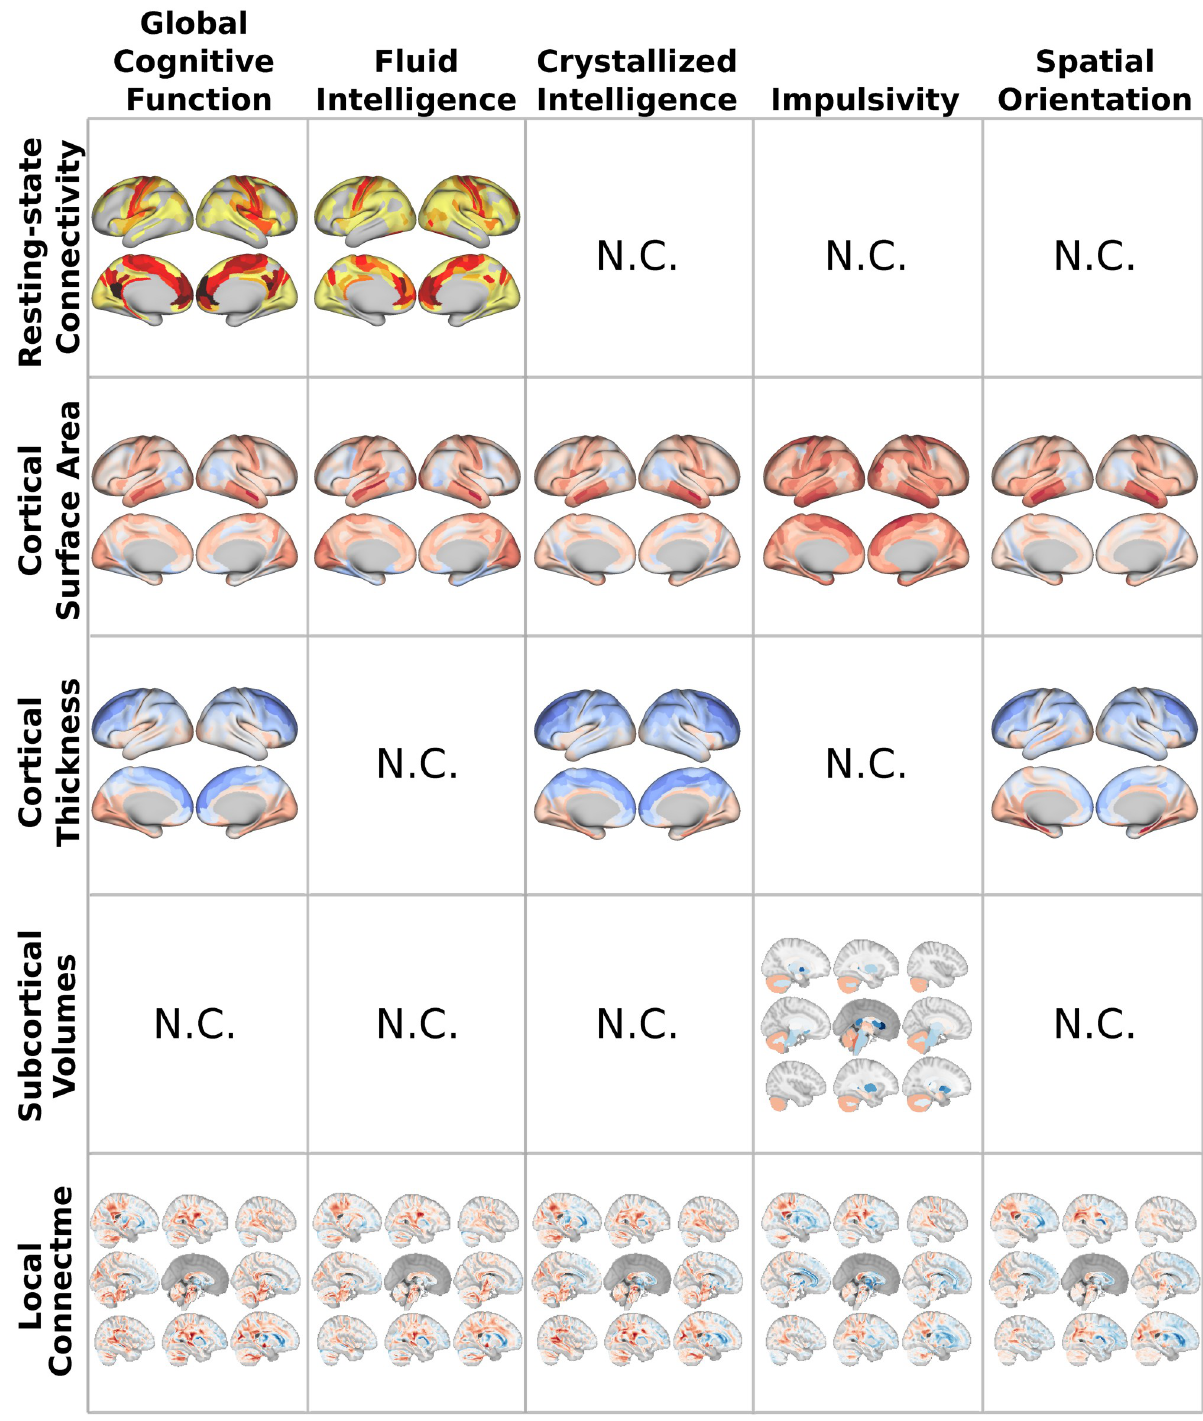
Fig 4. Multi-modal neuroimaging patterns from cognitive prediction. Encoding weight maps of each brain measurement whose contribution to predicting cognitive scores during stacking is statistically non-redundant (N.C. � Non-Contributing). Red and blue colors in the brain images ( i.e ., local connectome, cortical surface area, cortical thickness, and subcortical volumes) display positive and negative weights respectively. For the resting- state connectivity features the strength maps are instead displayed, estimated as the sum over the rows (or columns) in the absolute matrix of links’ weights, thresholded to concentrate only on their 1% largest values. The weight map for the volumetric properties in Crystallized Intelligence is marked as non-contributing (N.C.) since this channel did not survive after adding the confounders channel to the stacked model.